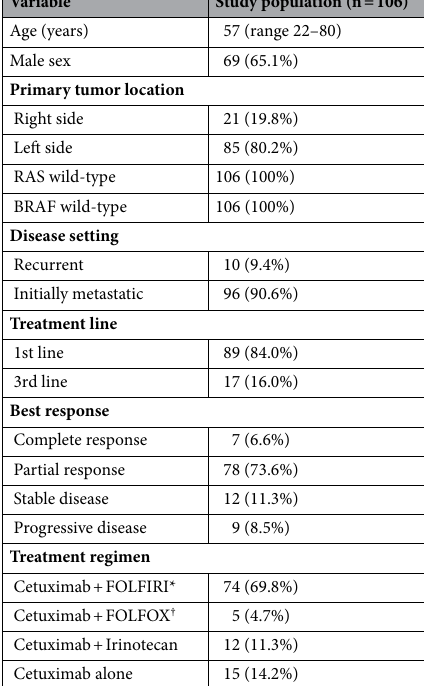
Table 1. Clinical characteristics of the study patients. *5-fluorouracil plus irinotecan. † 5-fluorouracil plus